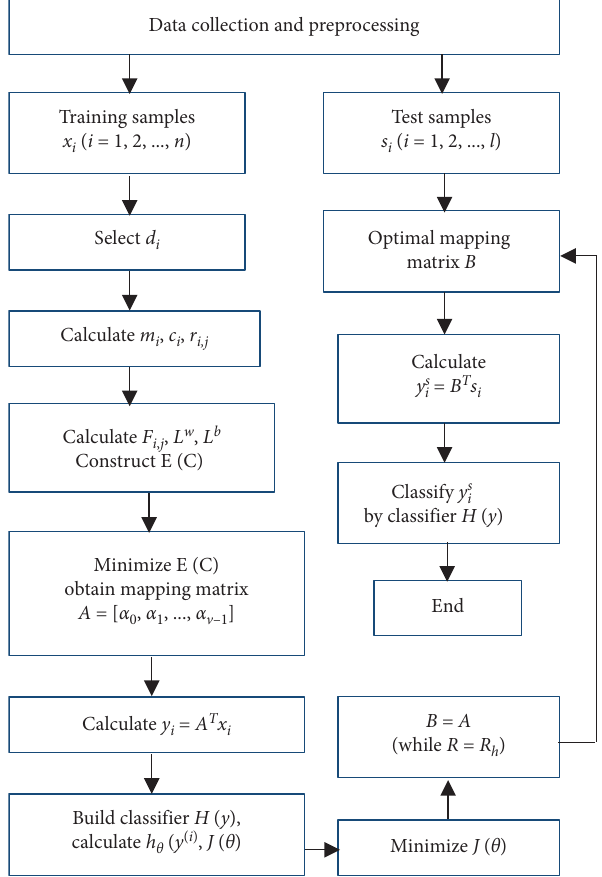
Figure 1: MLDA fault diagnosis